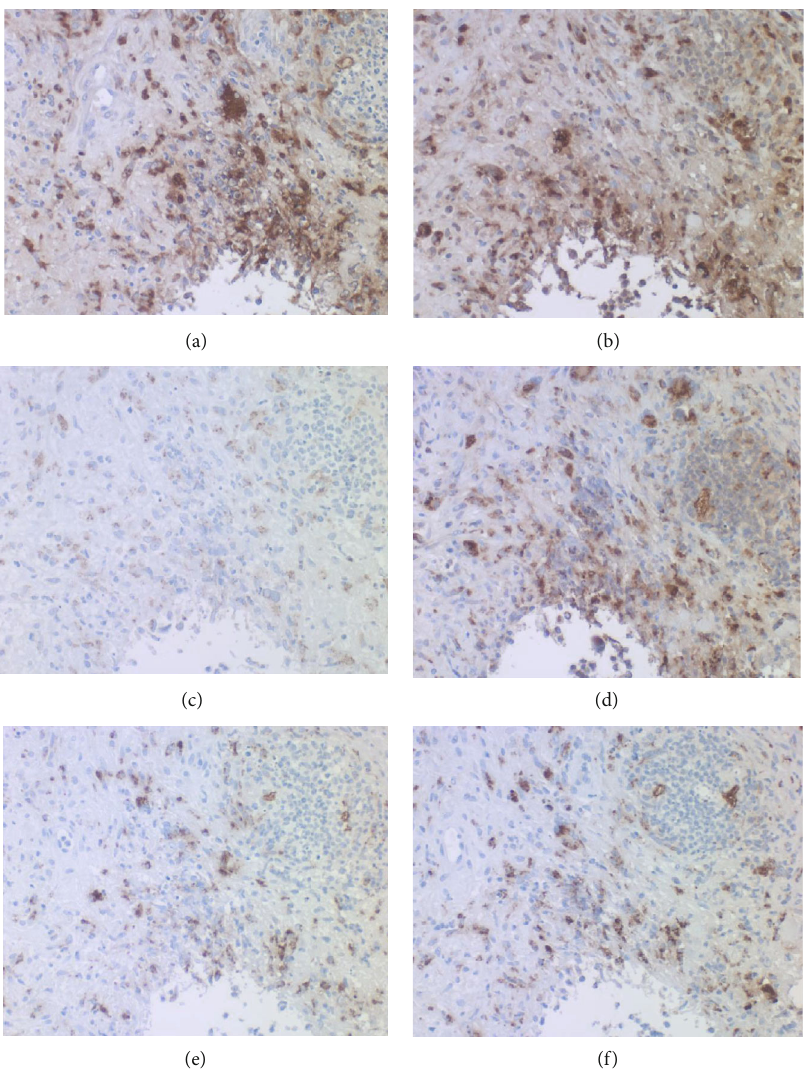
Figure 6: Immunohistochemical demonstration of varied bacterial antigens ((a) BCG, (b) Bacillus cereus , (c) Treponema pallidum , (d) MPT64, (e) LAM, and (f) PAB). The cytoplasm of macrophages in fi ltrating around the fat droplet exhibits clear cross-reactivity with varied bacterial antigens. Immunoreactivity of T. pallidum antigens is relatively